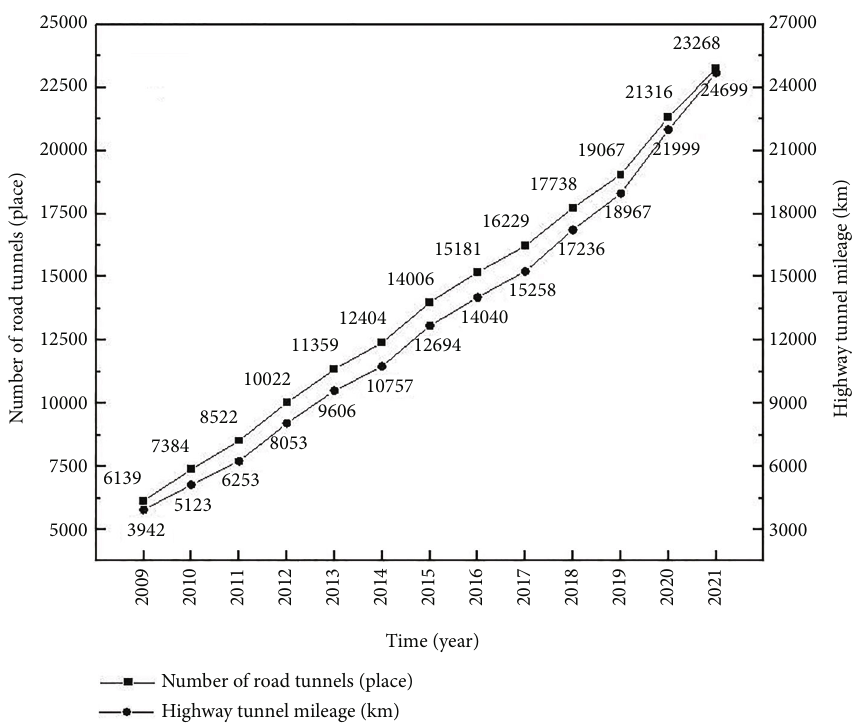
Figure 1: Growth curve of a road tunnel in China from 2009 to